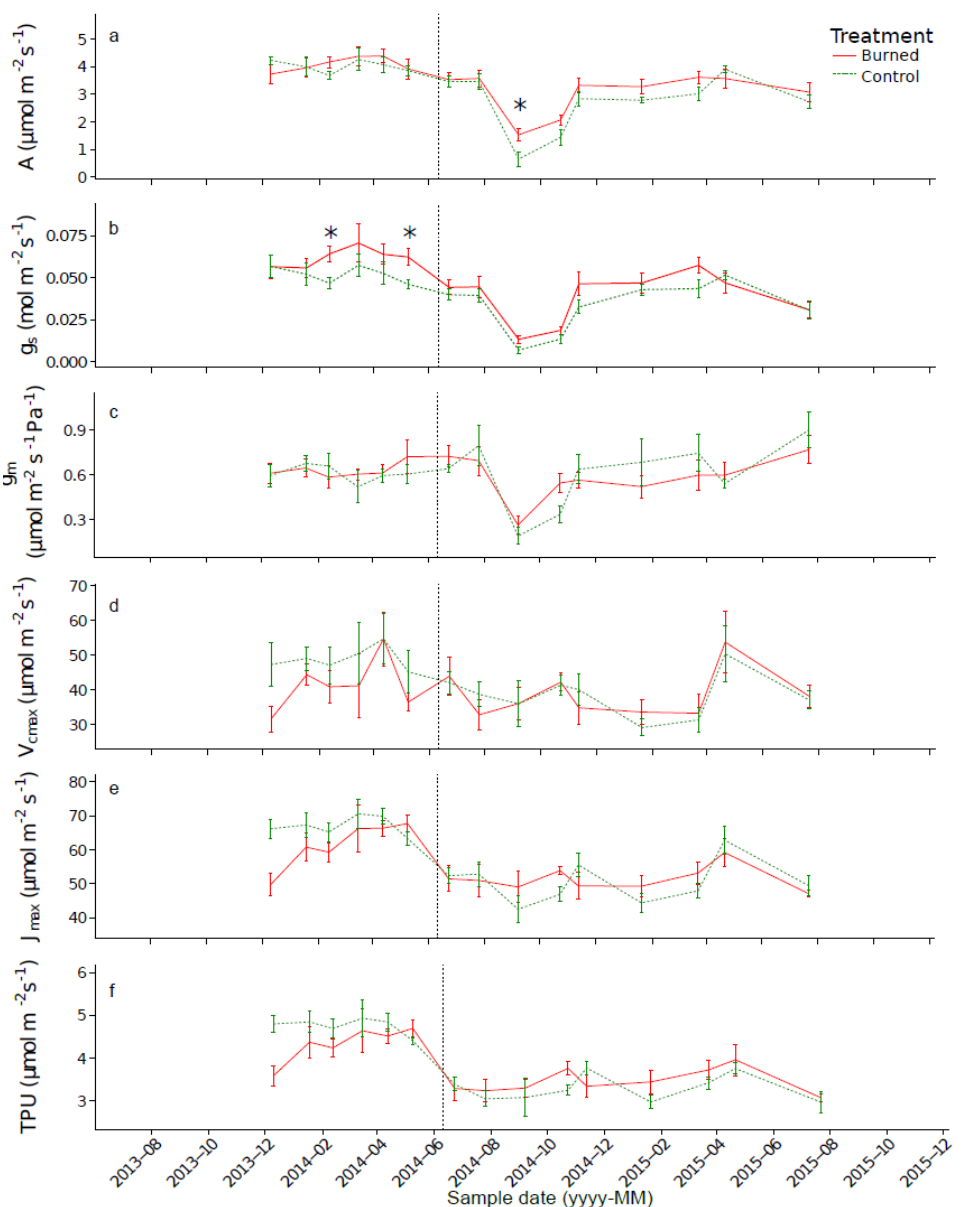
Figure 8. Mean values of A ( μ mol m – 2 s – 1 ; ( a ), g s (mol m – 2 s – 1 ; ( b ), gm ( μ mol m – 2 s – 1 ; ( c ), Vcmax ( μ mol m – 2 s – 1 ; ( d ), Jmax ( μ mol m – 2 s – 1 ; ( e ) et TPU ( μ mol m – 2 s – 1 ; ( f ). Significant differences between treatments are indicated by asterisks ( p < 0.05).